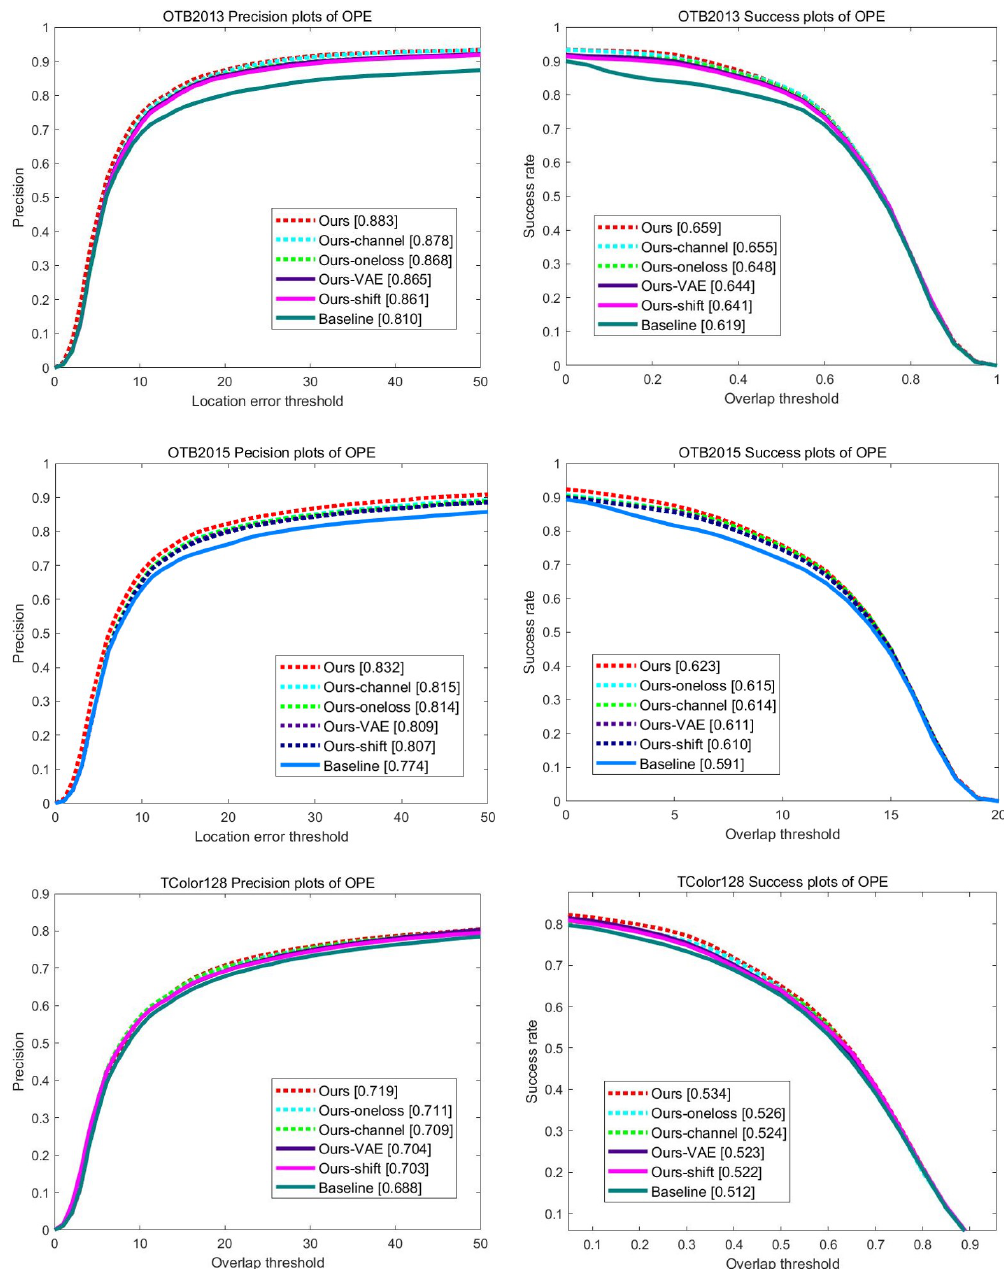
Figure 12. Internal comparison results of precision and success rate on OTB2013, OTB2015, and TColor128